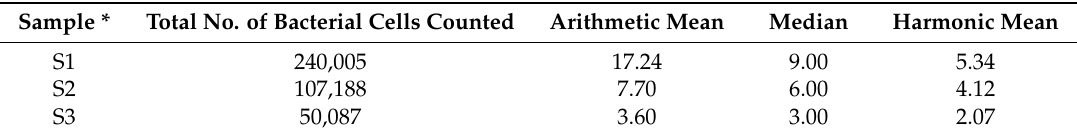
Table 2. Values of the measures of central tendency estimated from samples S1, S2 and S3.